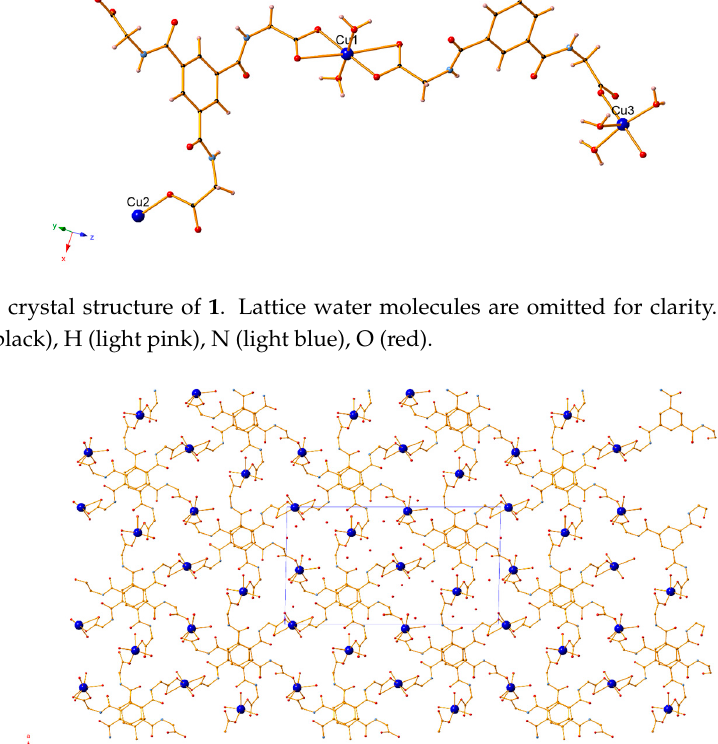
Figure 3. Coordination mode of the (L 1 ) 3 − organic ligand found in 1 . 3.2. Topological Analysis The complicated structure of compound 1 can be simplified into a net considering each ligand as a three-connected node and each metal center as a two-connected node; therefore, the two- connected nodes are not further considered for the classification. The final outcome of the topological analysis of the three-dimensional coordination polymer 1 , with the use of the TOPOS software [45]